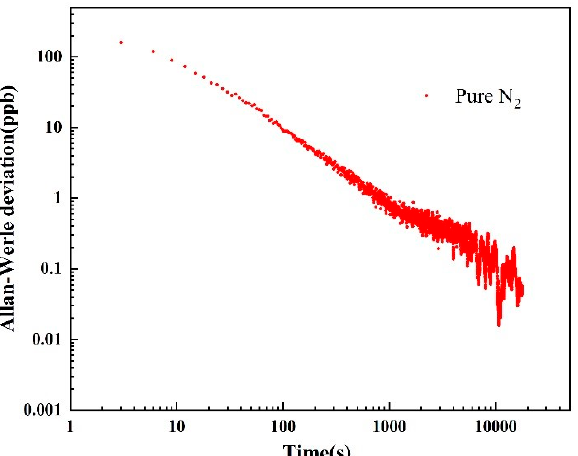
Figure 4. Allan-Werle deviation as a function of the integration time. The experimental data were obtained under the conditions of atmospheric pressure and room temperature.